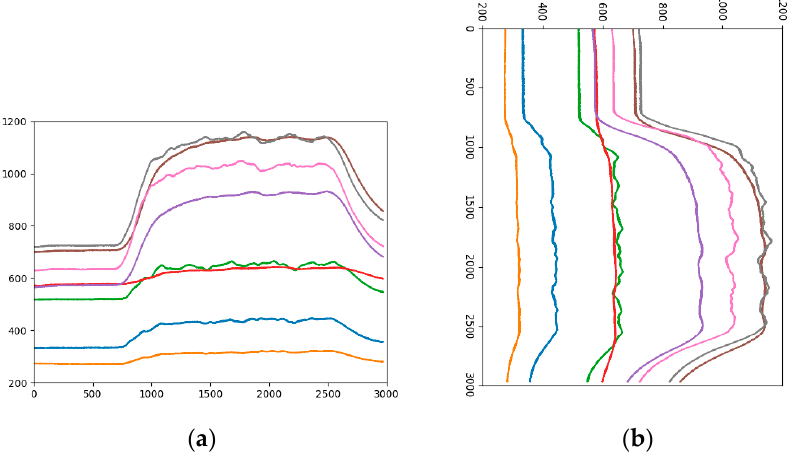
Figure 6. Unusual analogous-image ( a ) Low concentration of Methane; ( b ) Low concentration of Methane and Low concentration of Ethylene; ( c ) Low concentration of Methane and Medium concentration of Ethylene; ( d ) Low concentration of Methane.